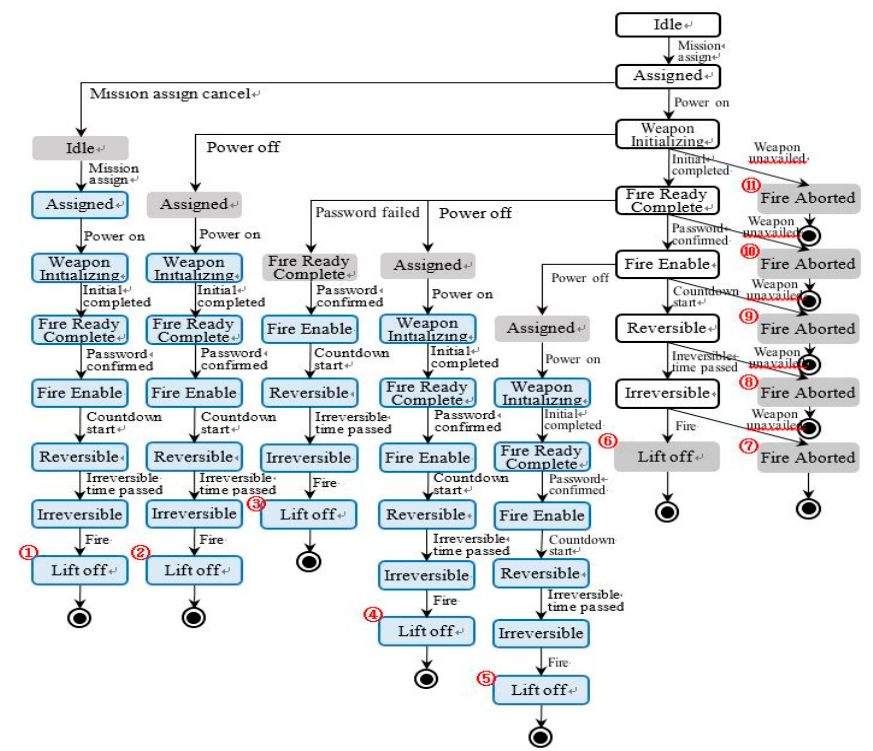
Figure 11. Tree derived using the propose method.